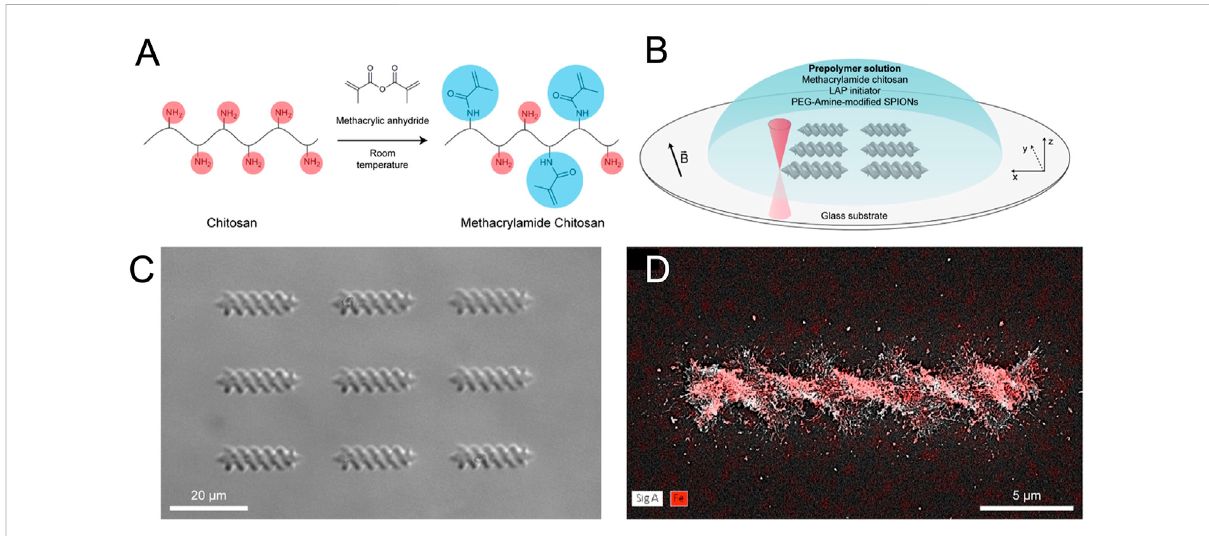
FIGURE 5 Synthesis and fabrication processes of magnetic microswimmers. (A) Synthesis of the photo-cross-linkable methacrylamide chitosan. (B) 3D printing of the microswimmers using two-photon direct laser writing technique. (C) Microscopy image of 3D-printed microswimmers. (D) Energy- dispersive X-ray spectroscopy elemental mapping showing the presence of iron atoms (red color) in the microswimmers. [Reproduced with permission from (Bozuyuk et al., 2018) Copyright 2018 American Chemical